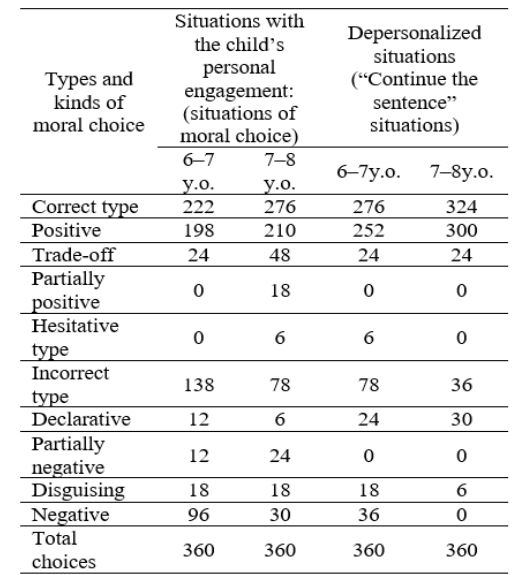
Table 2. Types and kinds of